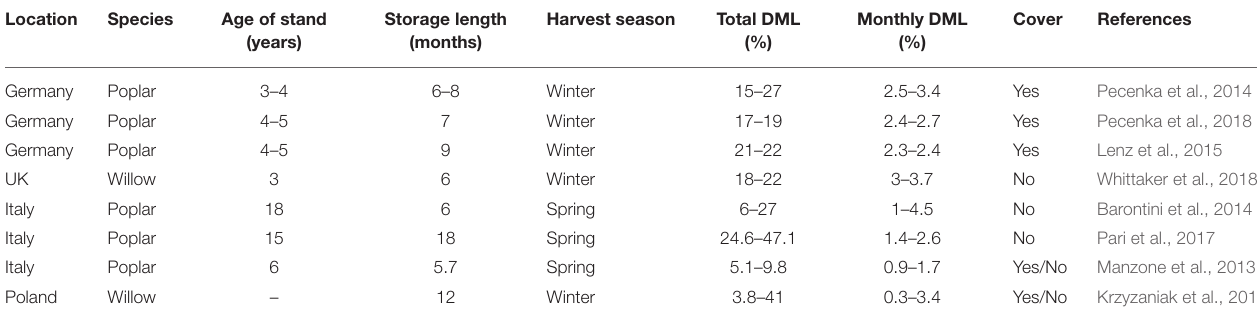
TABLE 1 | Reported values for dry matter loss (DML) for outdoor storage piles of willow and poplar chips. Location